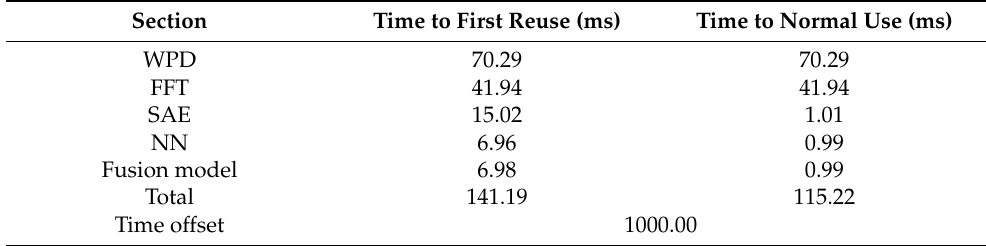
Table A2. The time required for the different sections of the fault diagnosis testing